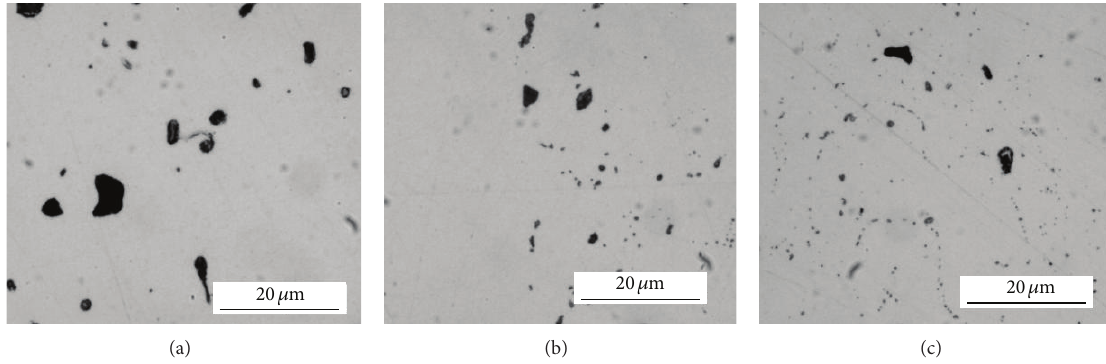
Figure 7: Oxide inclusions in AstCrM + 0.5% C components’ densities of (a) 6.5, (b) 7.1, and (c) 7.4 g/cm 3 sintered at 1120 ∘ C for 30min.